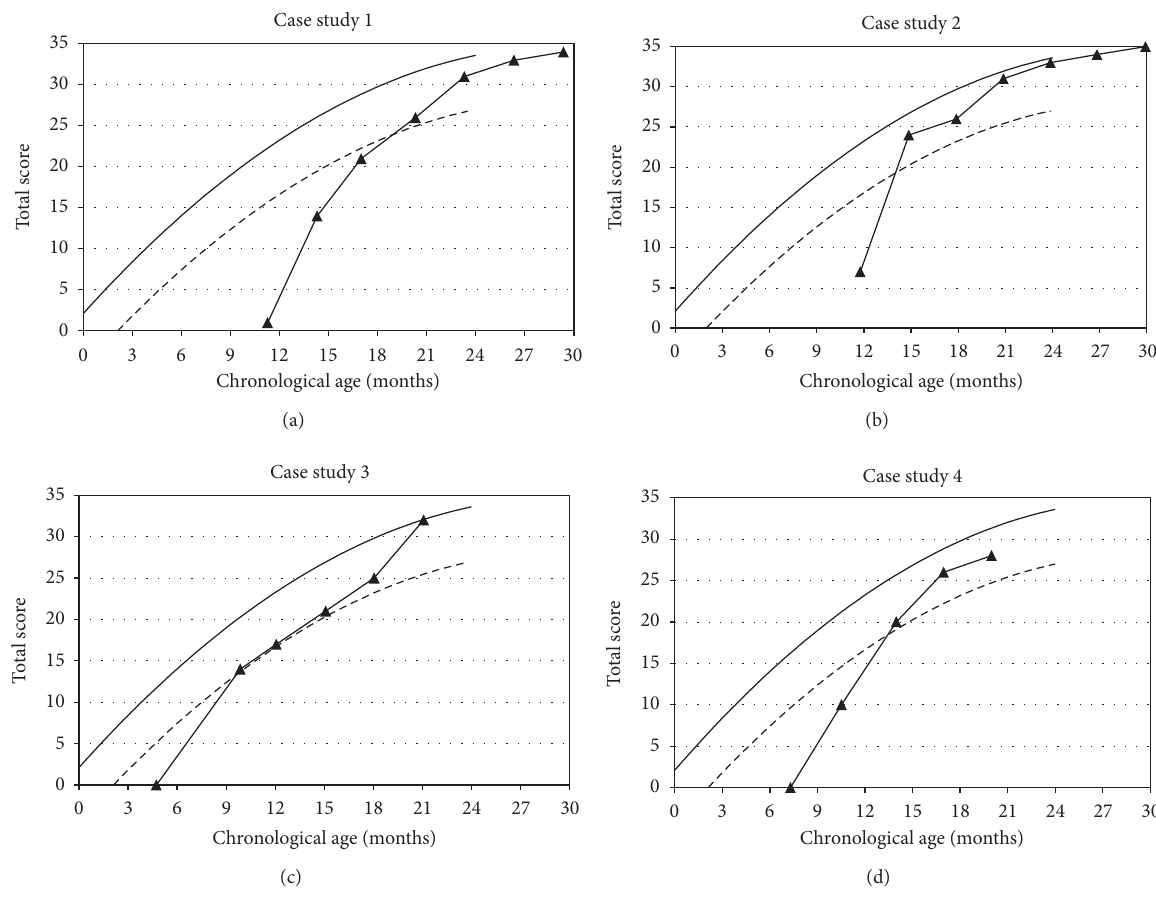
F 1: Auditory development as determined by the LittlEARS Auditory Questionnaire ((a)–(d)). e solid line denotes the German derived normative curve. e dashed line represents the minimum 95 con�dence interval values from the German-derived norms. Filled triangles denote the score of children ( -axis) at chronological age ( % 𝑦𝑦 𝑥𝑥